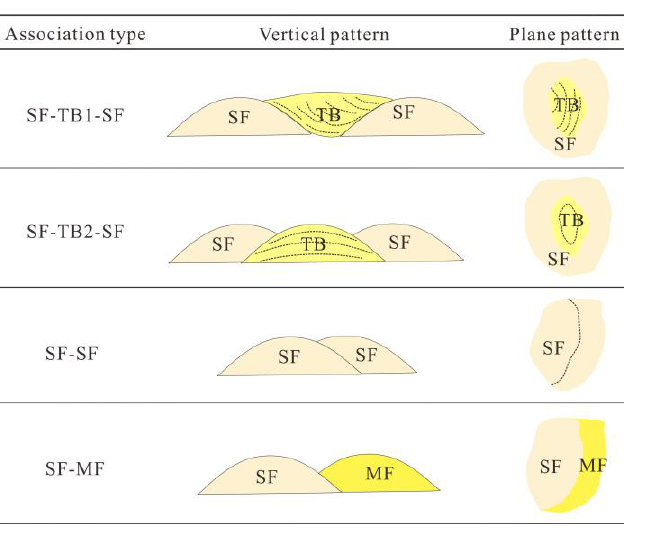
Figure 8. The superposition patterns of architectural elements. TB is tidal bar, SF is sand flat, and MF is mixed flat.